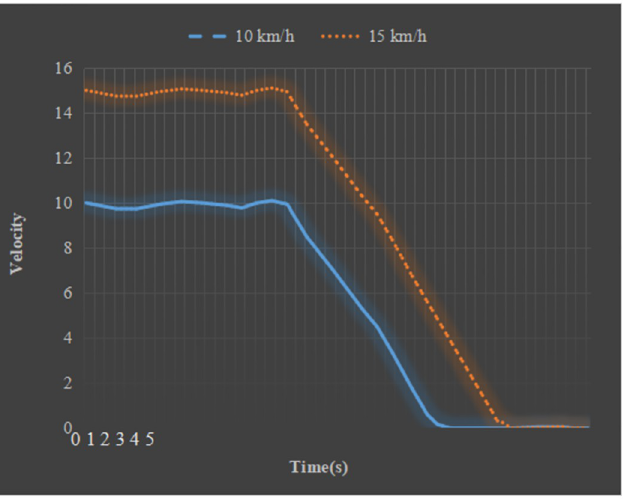
Fig 11. Changing curves of the emergency braking